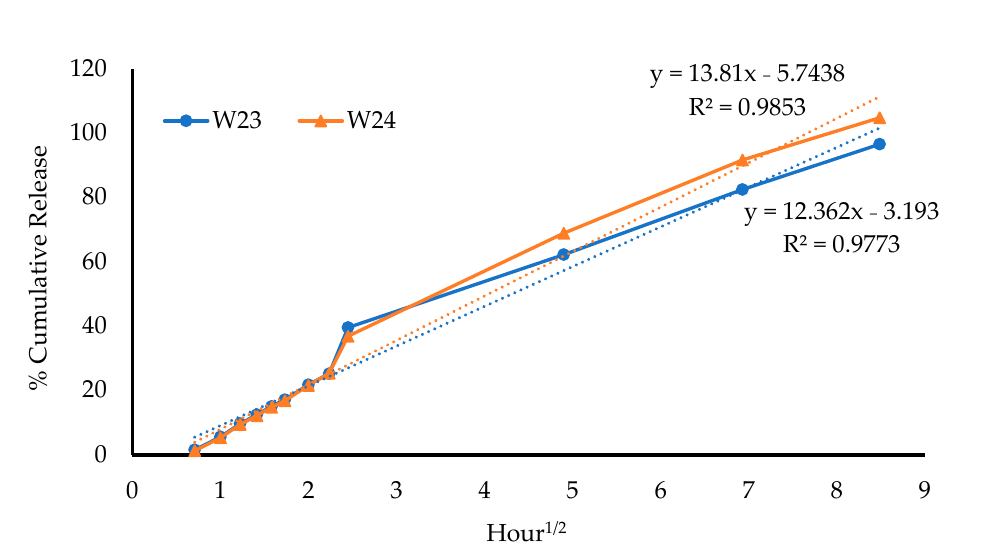
Figure 11. Kinetic curves calculated using the Higuchi equation, showing high correlation coefficients for both formulations.